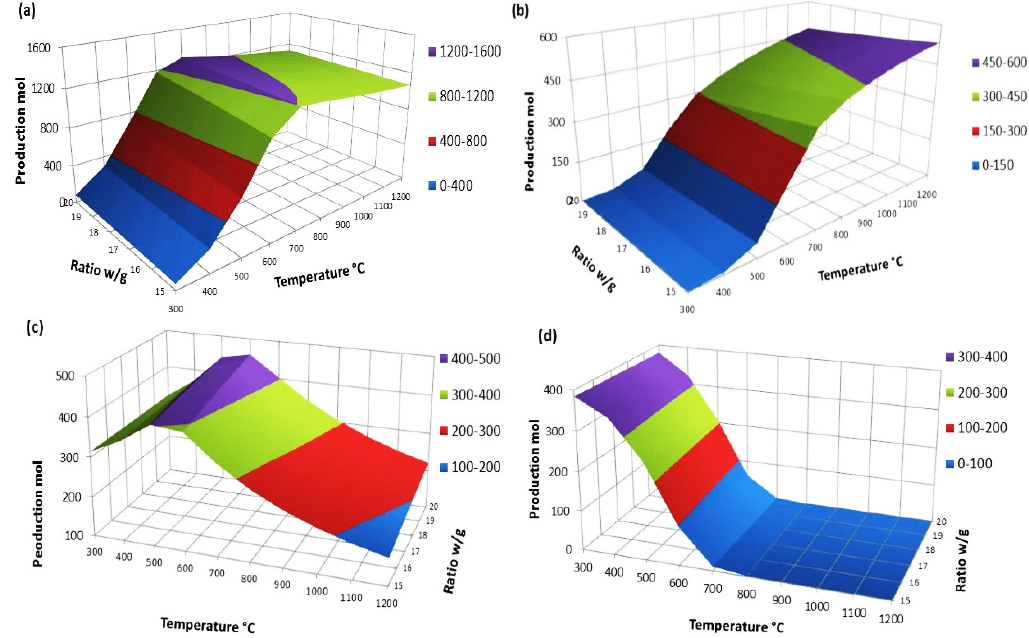
Figure 5. Mol production of ( a ) hydrogen, ( b ) carbon monoxide, ( c ) carbon dioxide and ( d ) methane at 0.1